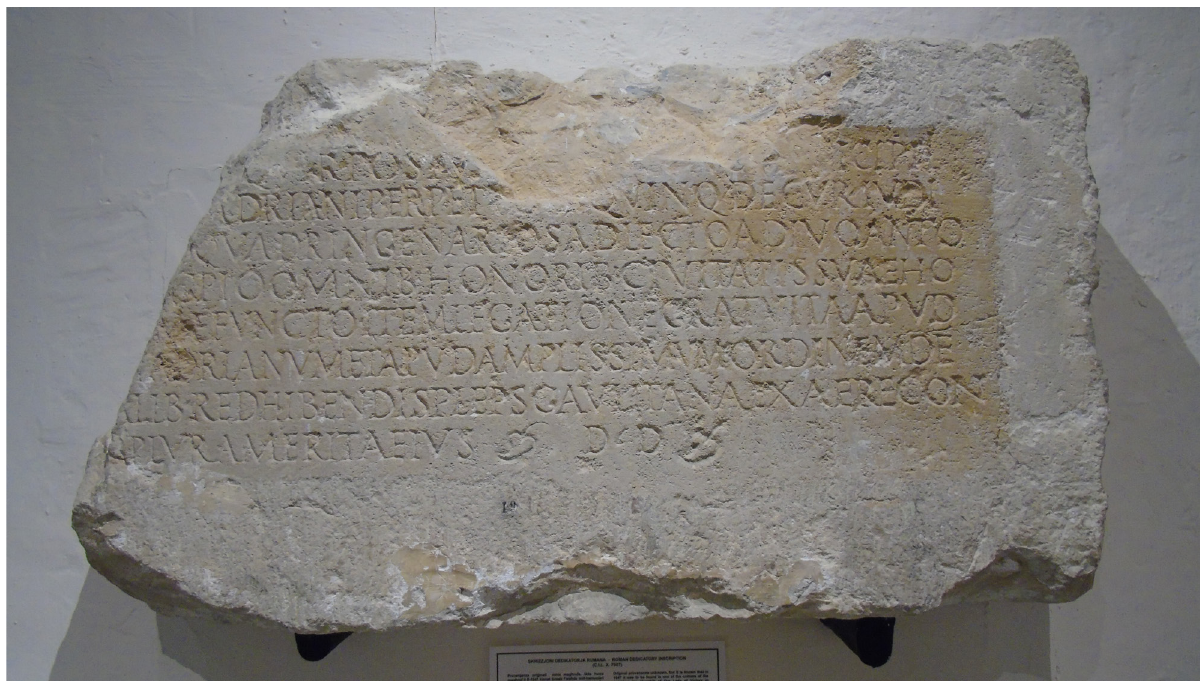
Figure 3: Inscription honouring C. Vallius Postumus (CIL X.7507) (Photo: author, courtesy of the Gozo Museum of Archaeology).